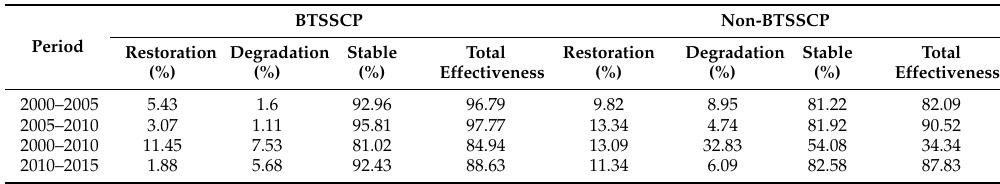
Table 3. The ratios of the restoration/degradation/stable area and the total effectiveness at BTSSCP and non-BTSSCP areas